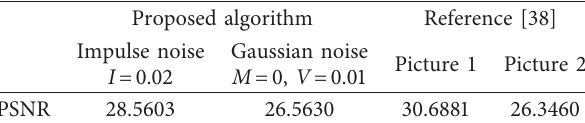
Table 7: Comparison of